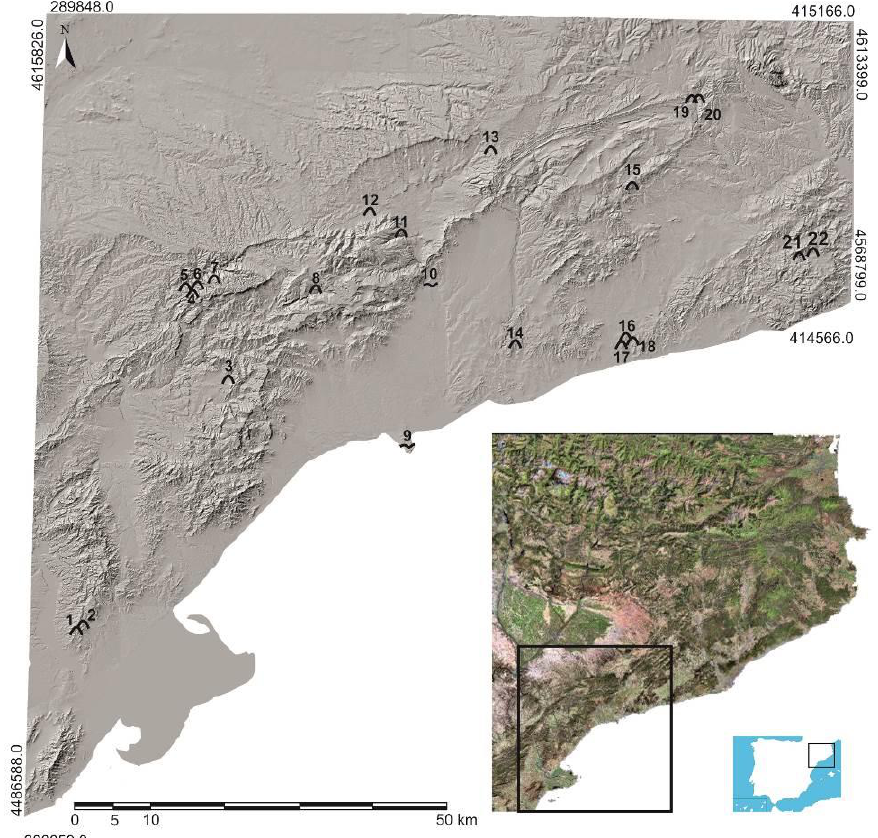
Figure 1 . Elevation Digital Model of the studied area (obtained from 1:25000 topographical maps www.icc.cat) with the location of different sites. 31N UTM with ETRS89 Datum.